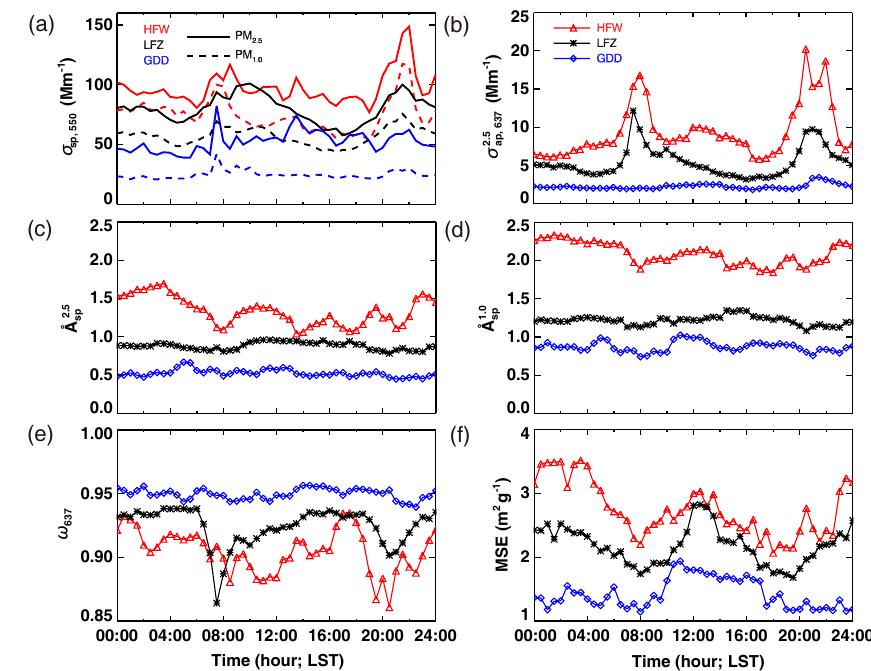
Figure 5. Diurnal variations in (a) aerosol scattering coefficient at 550nm, where solid lines represent the variations in PM 2 . 5 and dotted lines represent the variations in PM 1 . 0 ; (b) the aerosol absorption coefficient at 637nm and the scattering Ångström exponent for (c) PM 2 . 5 and (d) PM 1 . 0 (both calculated from 450 to 700nm); (e) single-scattering albedo at 637nm; and (f) mass scattering efficiency at 550nm in Wuwei (red lines), Zhangye (black lines), and Dunhuang (blue lines) from 3 April to 16 May 2014. Note that data collected during the strong dust storm in Zhangye are